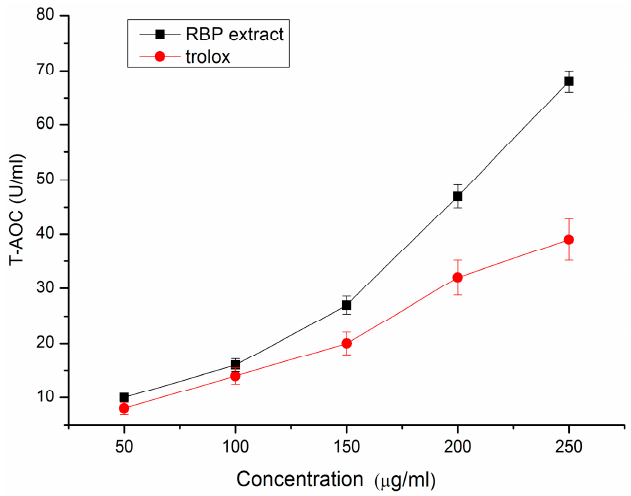
Figure 2. Total antioxidant capacity of RBP extract and trolox.